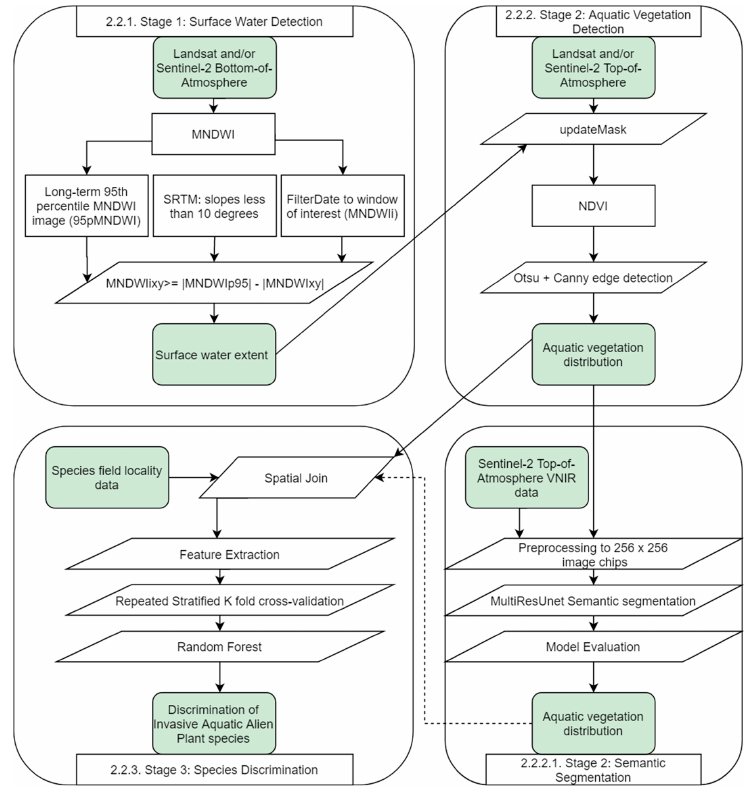
Figure 2. The general workflow used in this study to map and discriminate between invasive aquatic alien plant species across South Africa with input and terminal output data ( green rectangles ), intermediate outputs ( white rectangles ) and processes ( parallelograms ). The dashed arrow indicates the alternative (potential) use of the MultiResUnet derived aquatic vegetation (Section 2.2.2.1) for water hyacinth discrimination (Section 2.2.3.). Refer to electronic color copy for the reference to color.